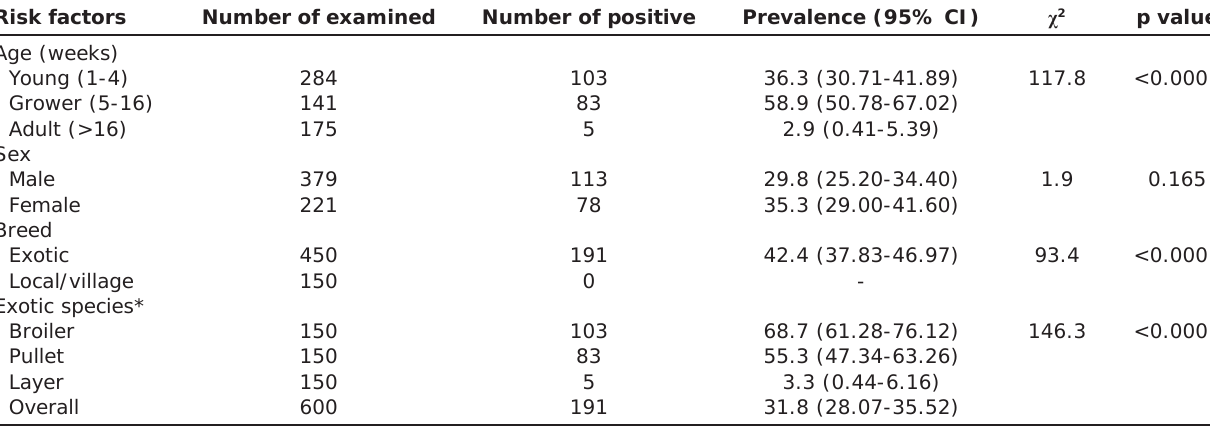
Table-1: Risk factors associated with avian coccidiosis in Maiduguri, Northeastern Nigeria (n=600). Risk